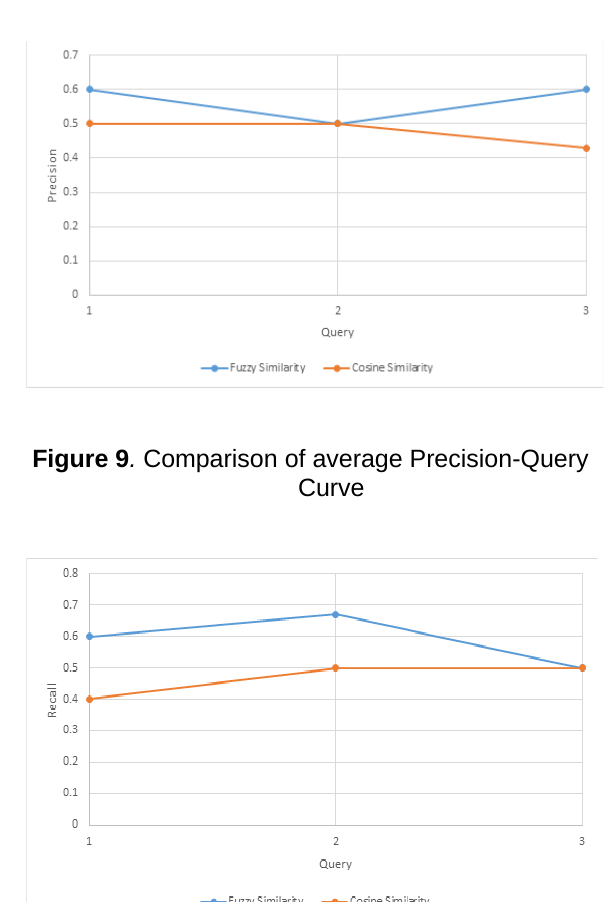
Figure 8 . Comparison of Precision-Recall Curve